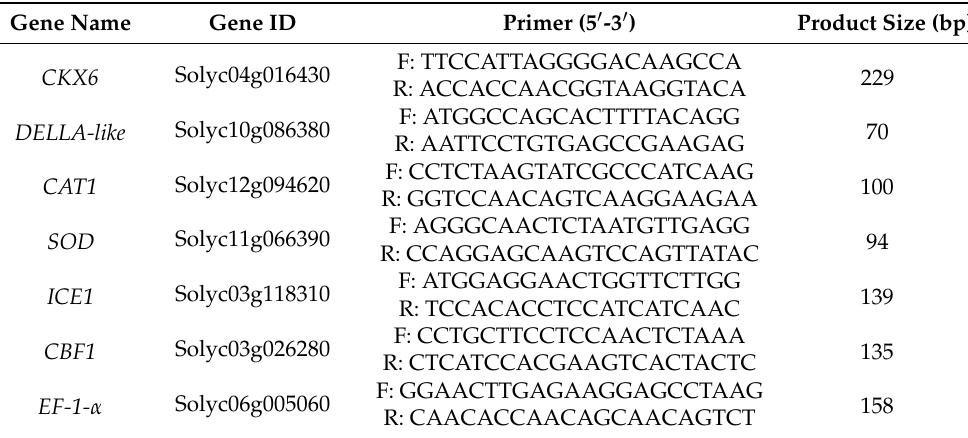
Table 1. List of primers of the studied